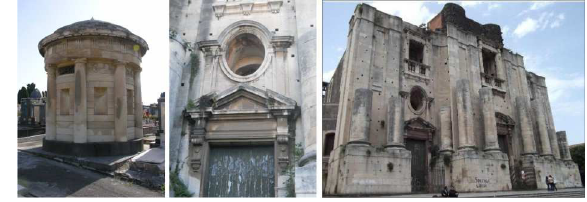
Figure 5: Datasets used for metric accuracy tests 3D model made in 123D Catch has been exported in obj format.